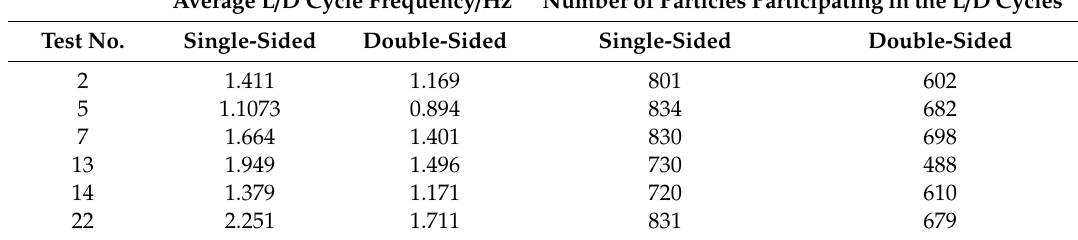
Table 5. Average L / D cycle frequencies and numbers of particles participating in the L / D cycles for typical combinations under di ff erent illumination modes. Average L / D Cycle Frequency / Hz Number of Particles Participating in the L / D Cycles Test No. Single-Sided Double-Sided Single-Sided Double-Sided